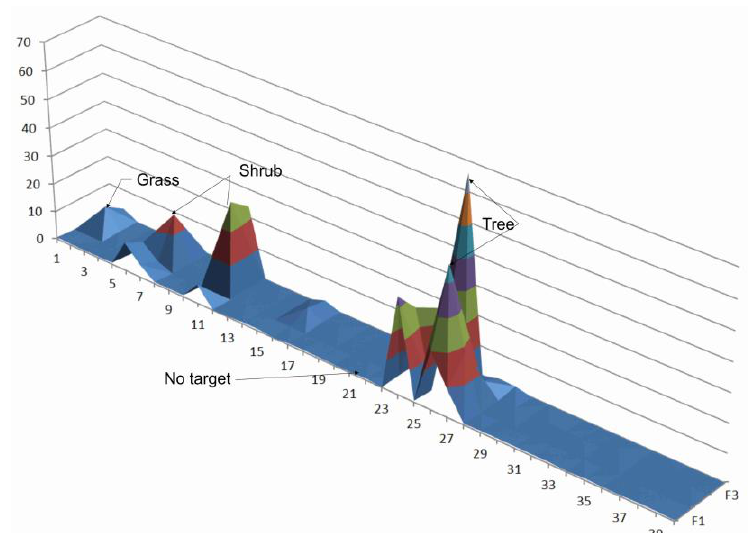
Fig. 4. Observation contributions for the scene without a target. The simulation results were confirmed experimentally.